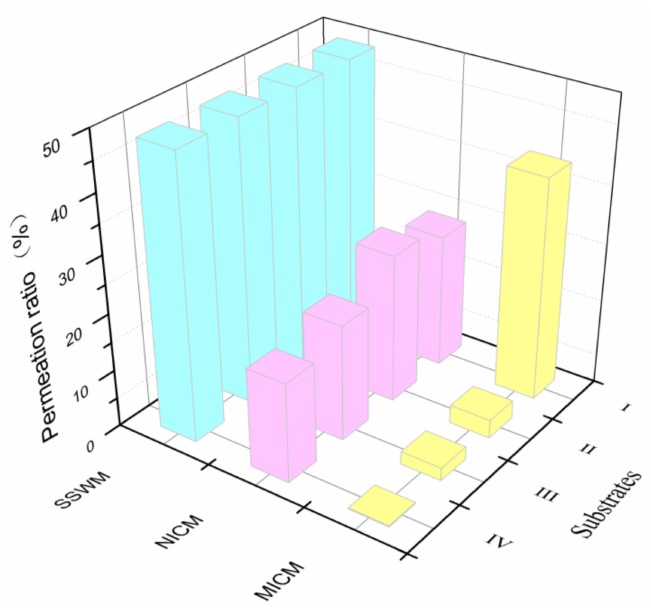
Figure 12. Permeation Selectivity of ECB-MICMs to ECB.